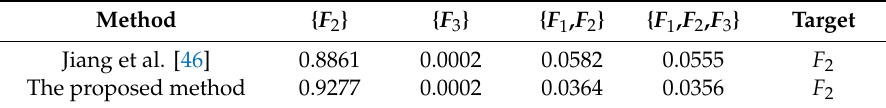
Table 5. Fusion results of di ff erent methods for motor rotor fault diagnosis at 1 X frequency.